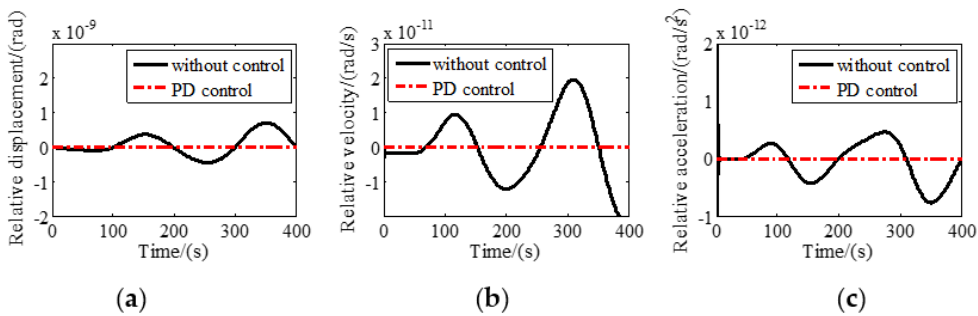
Figure 5. Relative motion with and without tracking control around Z direction: ( a ) Relative displacement; ( b ) relative velocity; ( c ) relative acceleration.